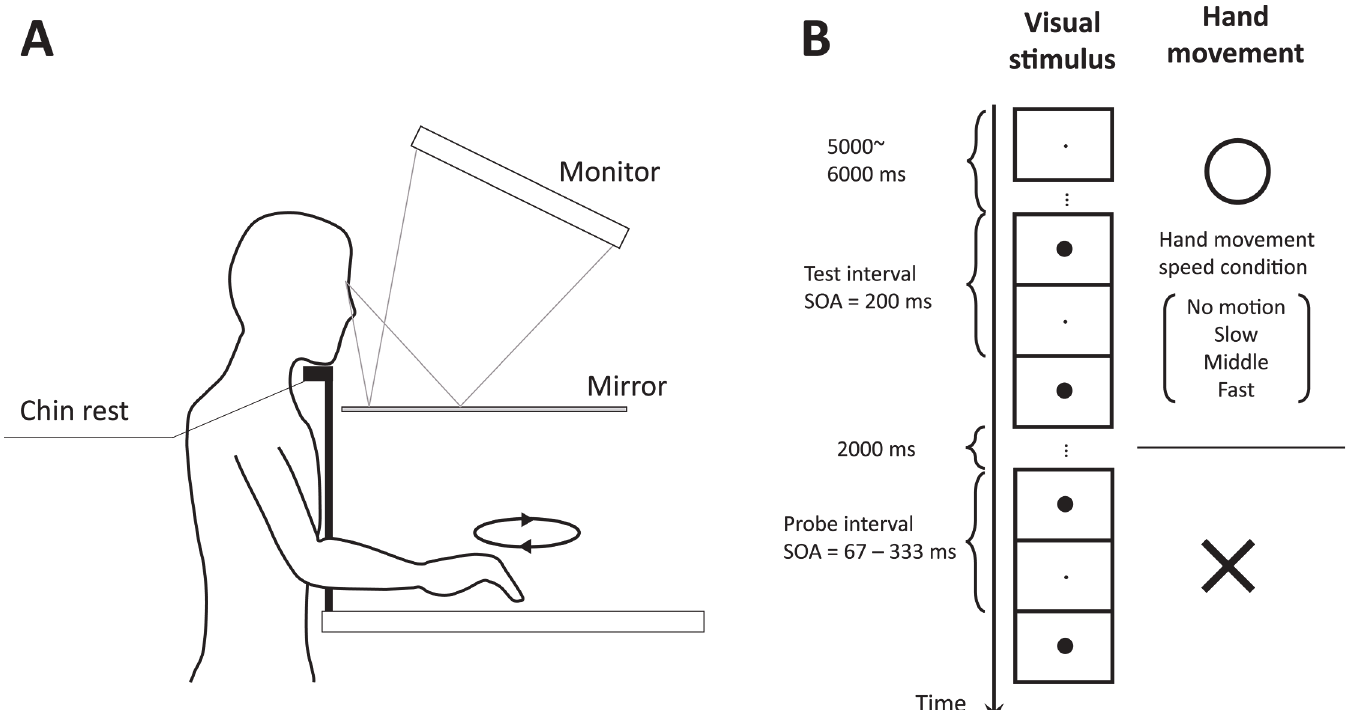
Fig 1. Schematic illustration of the experimental setup and time course. (A) Experimental setup. (B) Time course of a stimulus for the experimental conditions.